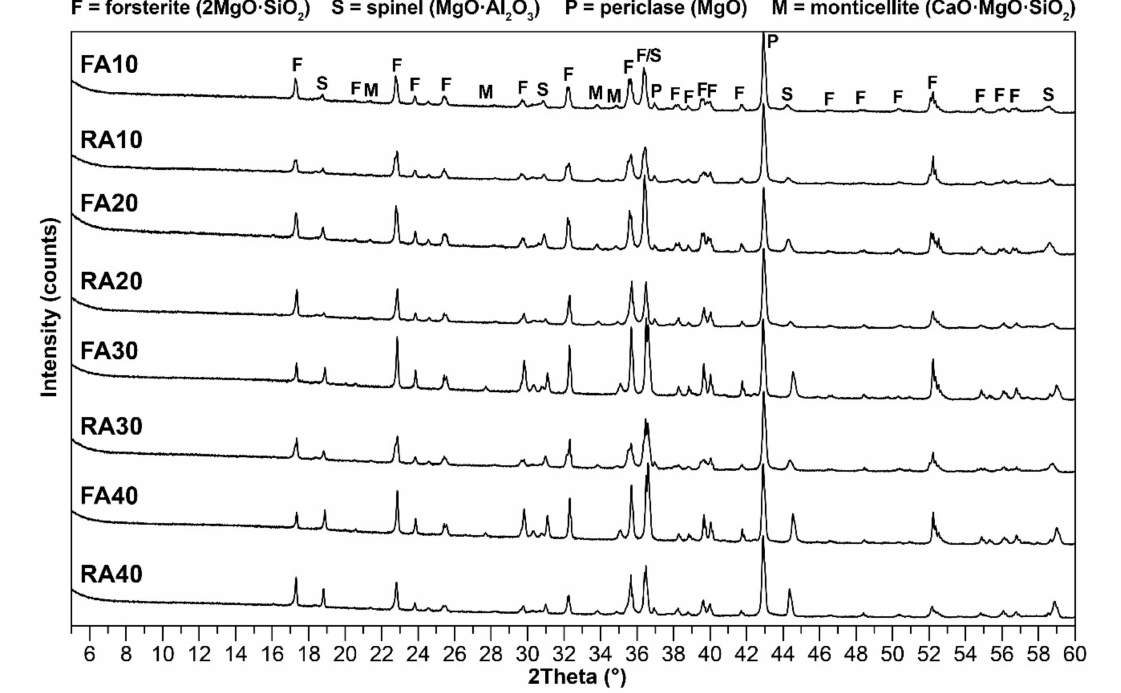
Figure 4. Comparison of the X-ray di ff raction analysis of all designed samples with fly ash (FA10-FA40) or alumina